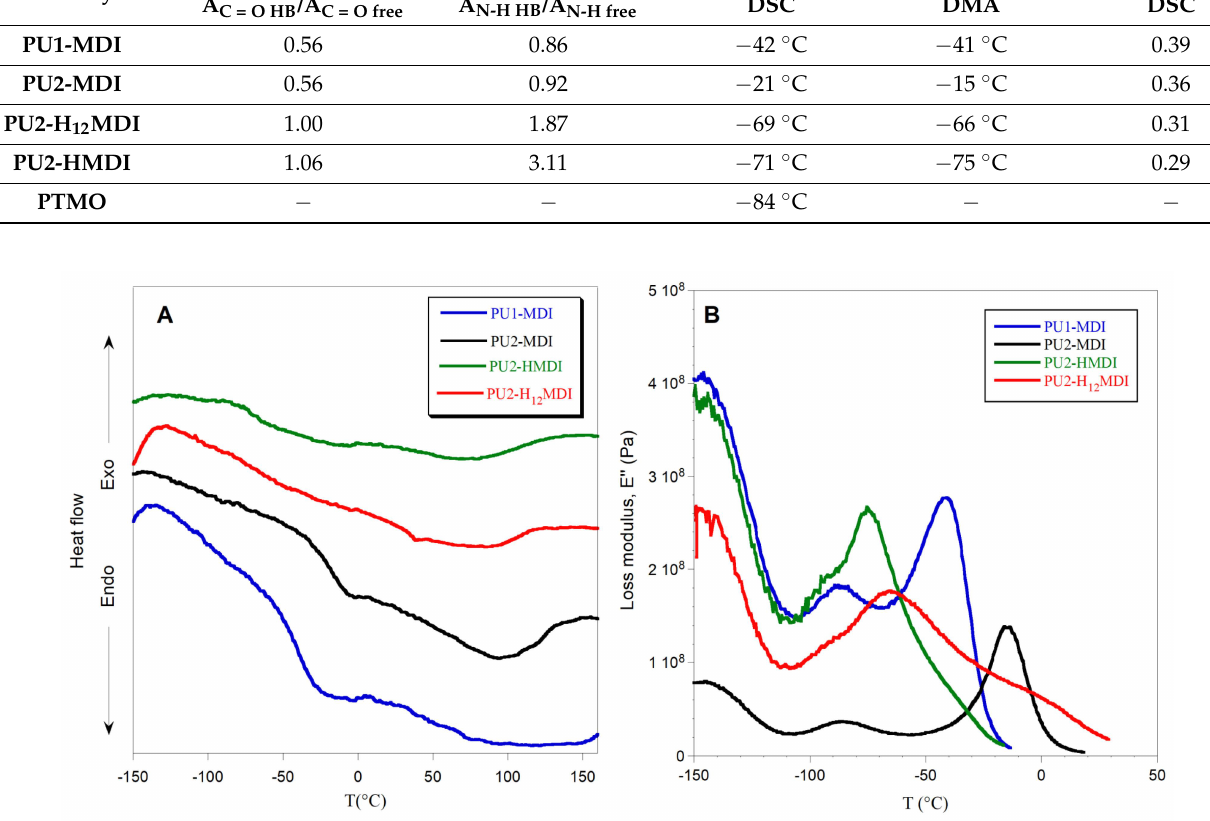
Figure 3. DSC thermograms ( A ) and loss modulus E” ( B ) of